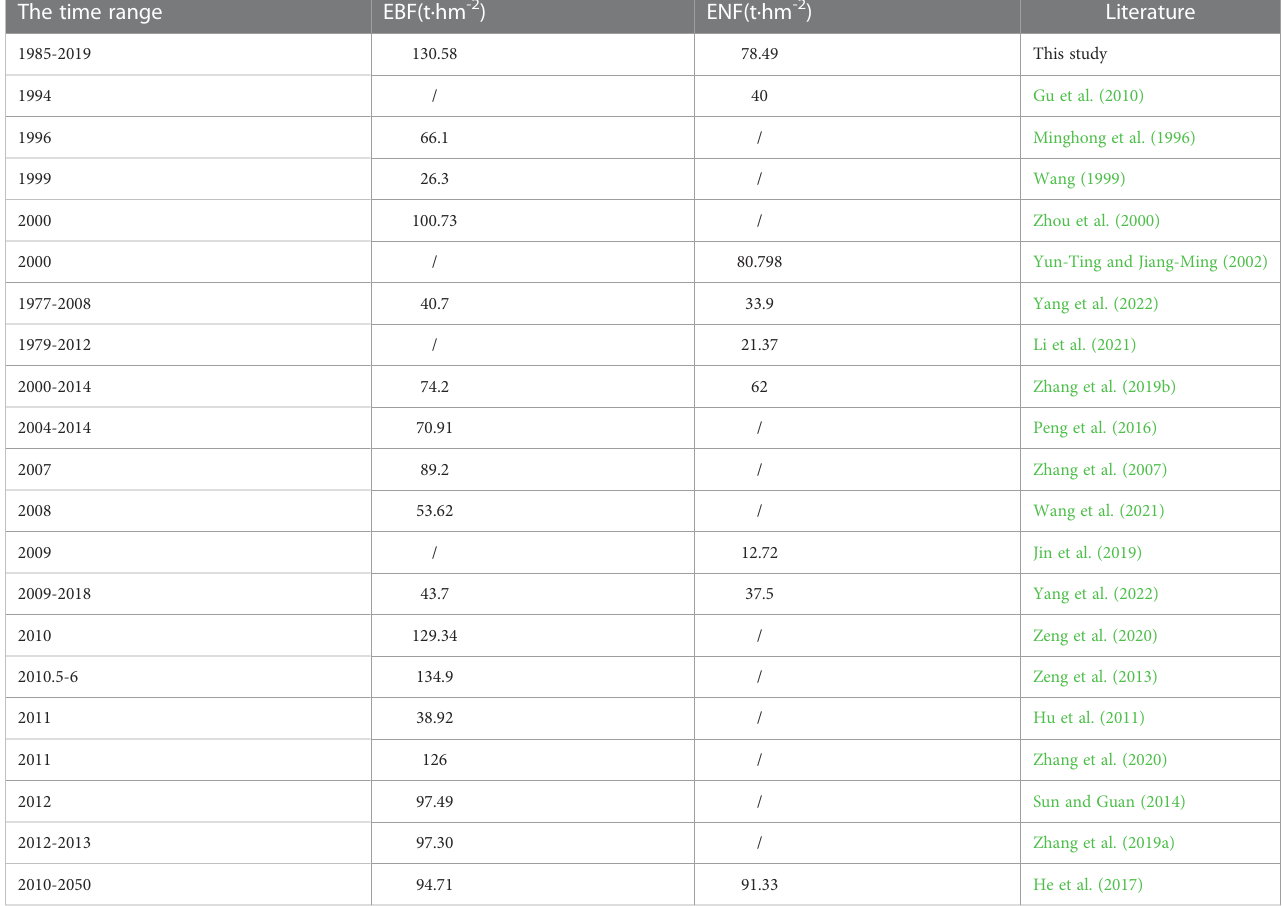
TABLE 5 Comparison between the mean values of carbon storage of two forest types simulated in this study and previous studies. The time